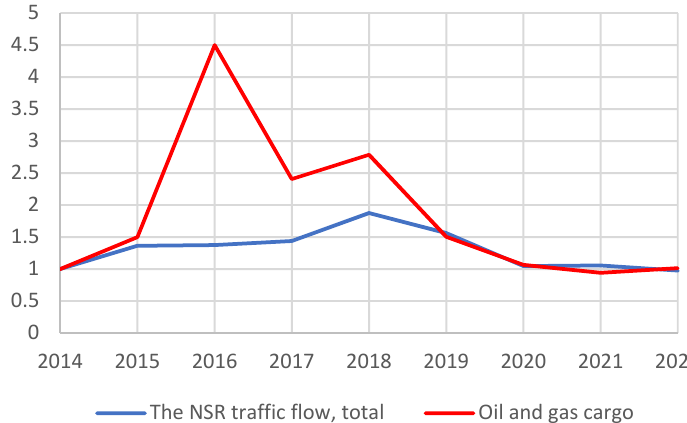
Figure 7. Chain indices of the total volume of the NSR traffic flow and oil and gas cargo transportation in 2014–2022 units. Source: compiled by the author according to the data of [6,38,44,57,58].